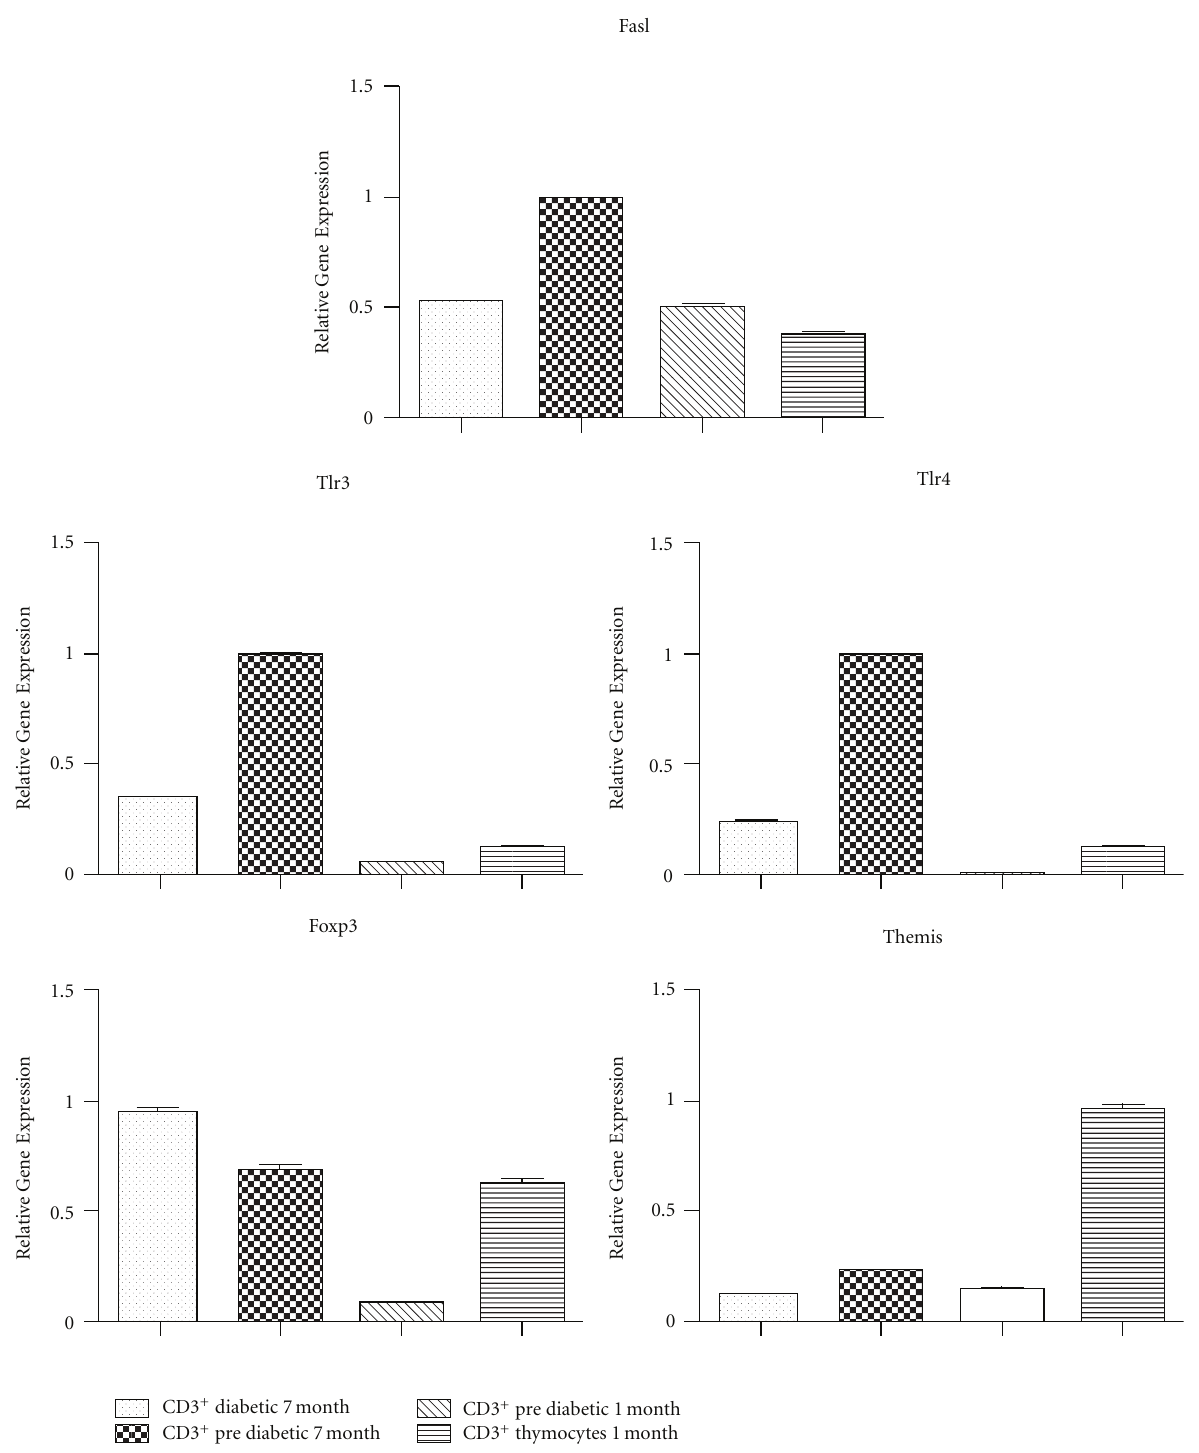
Figure 4: Confirmation of microarray data by qRT-PCR. The Fasl, Tlr3, and Tlr4 genes were downregulated in thymocytes from prediabetic animals, Foxp3 was upregulated in peripheral CD3 + lymphocytes from diabetic animals, and Themis was upregulated in thymocytes from prediabetic